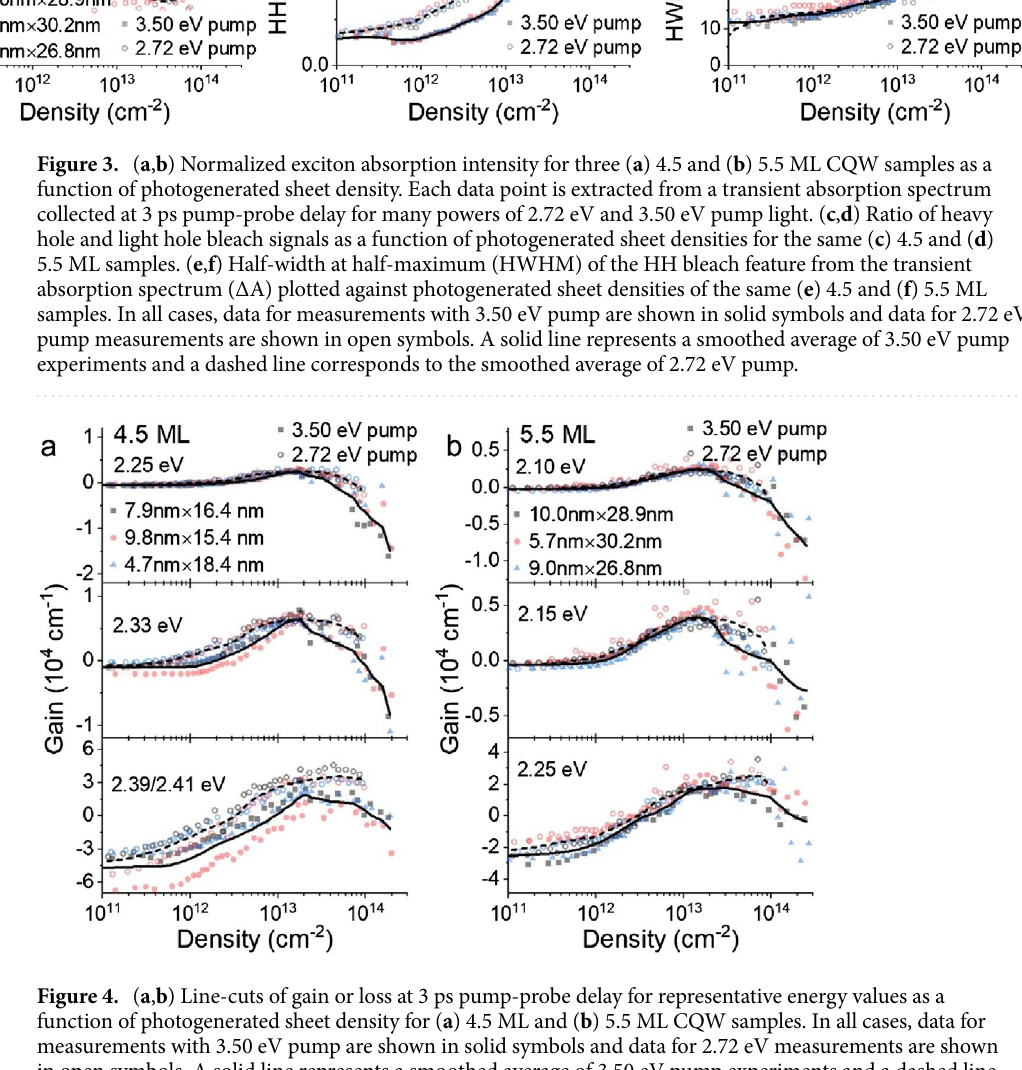
showing the half-width at half-maximum of the transient absorption heavy hole bleach features. The broadening of the transient absorption bleaching features at high electron–hole densities, which appears largely insensitive to the photoexcitation energy, reflects both multiple exciton physics ( e.g. the formation of biexcitonic species and concomitant stimulated emission) and increases in lattice temperature, as demonstrated in temperature- dependent spectroscopy below.